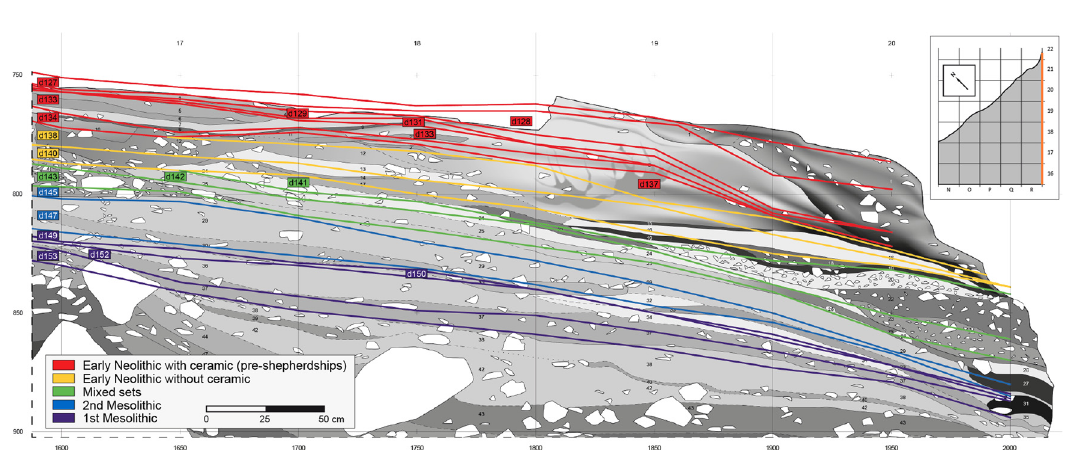
Figure 5: Stratigraphic section S40 showing the archaeological levels from the First Mesolithic to the Early Neolithic pre - shepherdships in band R17 - 21 ( sector NR16 - 21 ) . The coloured lines correspond to the limits of each decapages ( identi fi ed in the rectangles ) . CAD: Cyril Bernard ( AVDPA ) and Marc - André